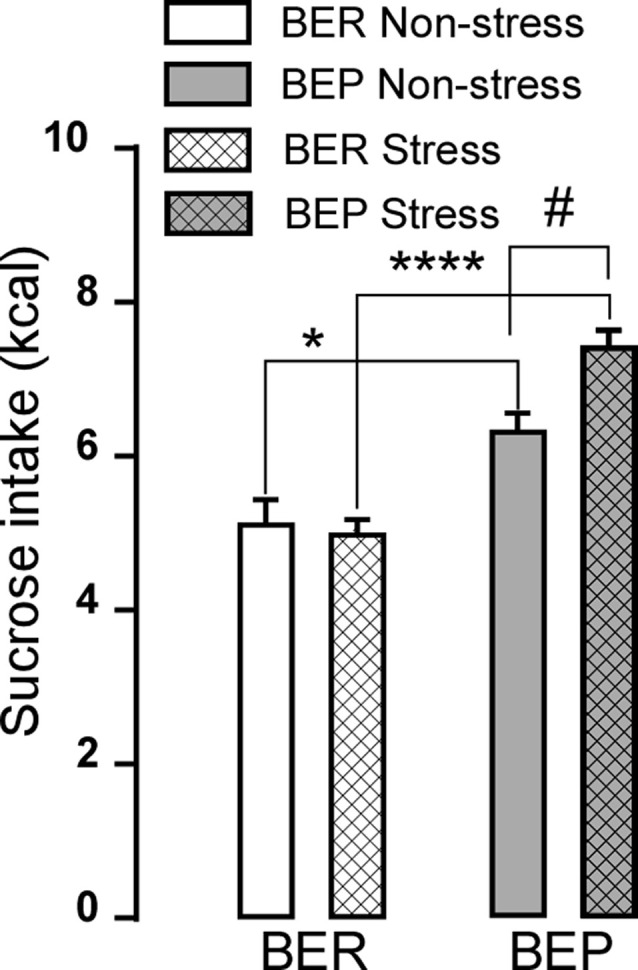
Sucrose intake during phenotyping. The graph shows the 10% sucrose consumption in kilocalories by binge eating prone (BEP) and binge eating resistant (BER) rats during a 1-h access without foot-shock stress (non-stress) and after foot-shock stress (stress). Comparison between phenotypes *p < 0.05; ****p < 0.0001; comparison within phenotype #p < 0.05.